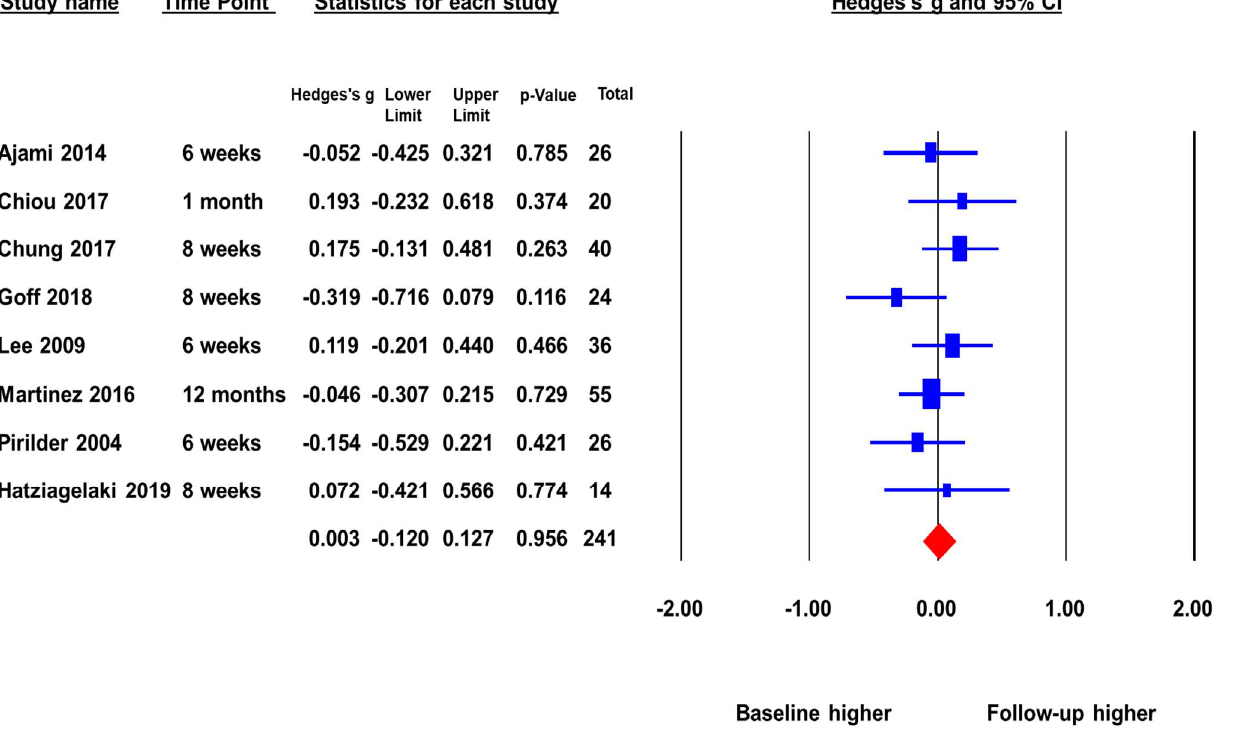
Figure Figure 3. Peripheral BDNF levels in first episode psychotic patients before and after antipsychotic treatment.